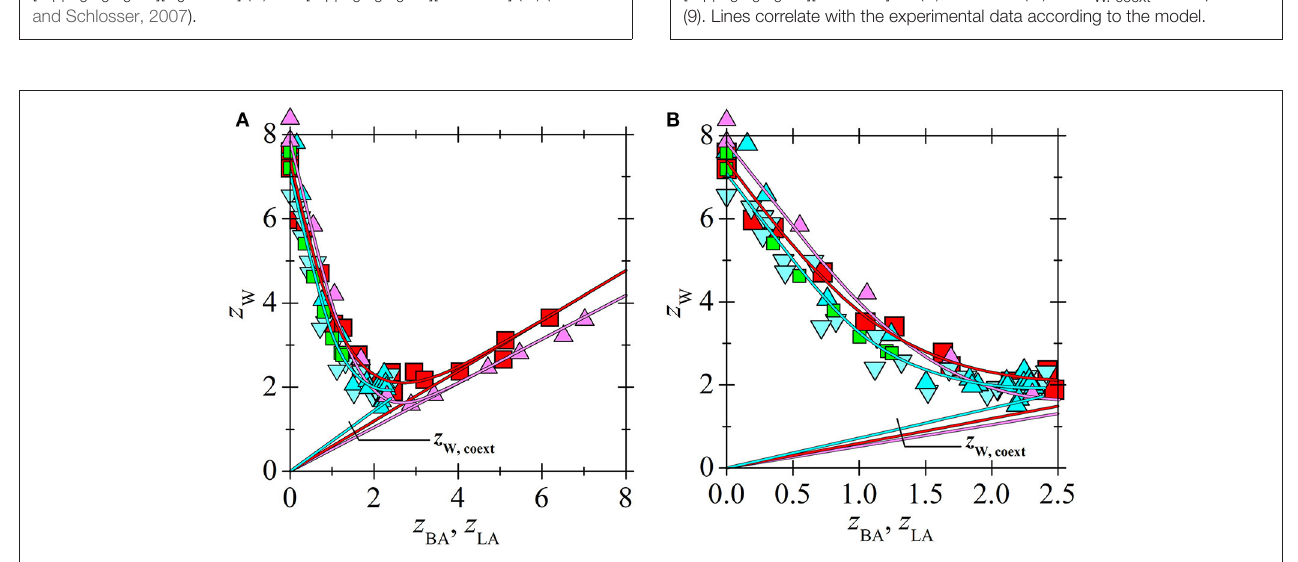
FIGURE 9 | Loading of phosphonium ILs by water vs. loading of IL by acid for the same systems as in Figure 6 . (BA + undiluted [C 14 C 6 C 6 C 6 P + ][BTMPP − ]) ( ) (Marták and Schlosser, 2016), (BA + undiluted [C 14 C 6 C 6 C 6 P + ][C 9 COO − ]) ( ) (Marták and Schlosser), (LA + undiluted ( ) or 70 wt. % ( ) [C 14 C 6 C 6 C 6 P + ][BTMPP − ] in dodecane) (Marták and Schlosser, 2007) and (LA + undiluted [C 14 C 6 C 6 C 6 P + ][C 9 COO − ]) ( ). Diluent was dodecane. For z W. coext see Equation (9). Lines correlate with the experimental data according to the model. (B) The extended view of the lower acid loading range of (A) .